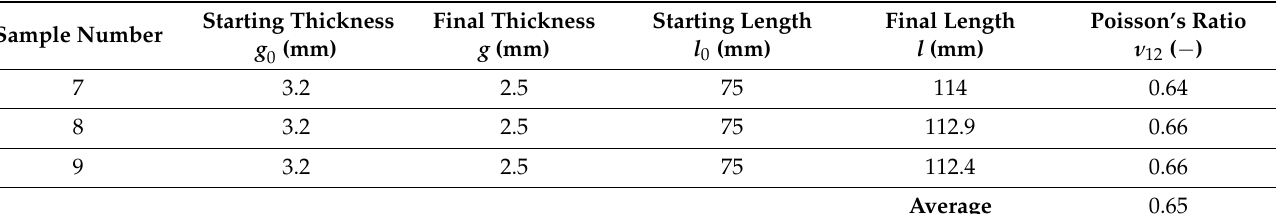
Table 6. Measurements results of samples with lamination angle 90 ◦ without envelope